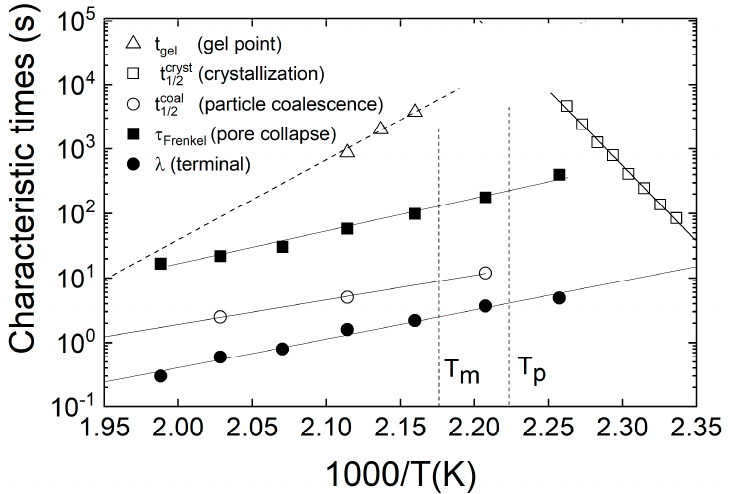
Figure 9. Characteristic times (see text) versus inverse temperature for the sintering of polyamide 12.